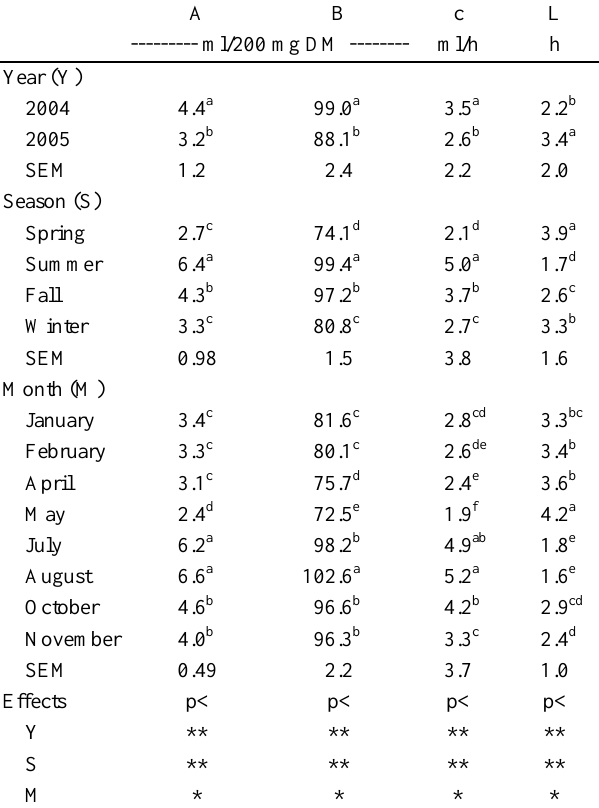
abcdef Means with different superscripts, within column, are